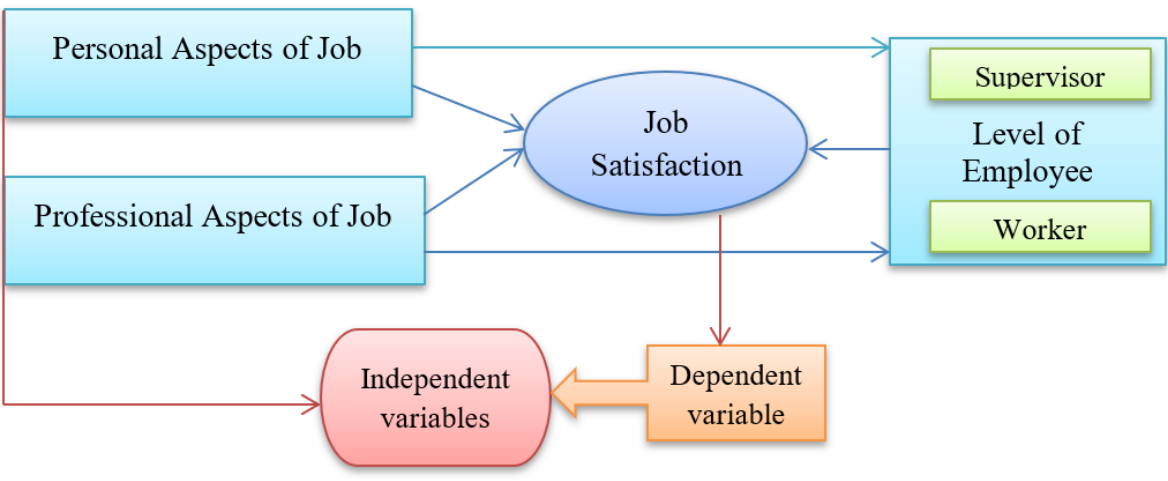
Figure 1. Research framework.